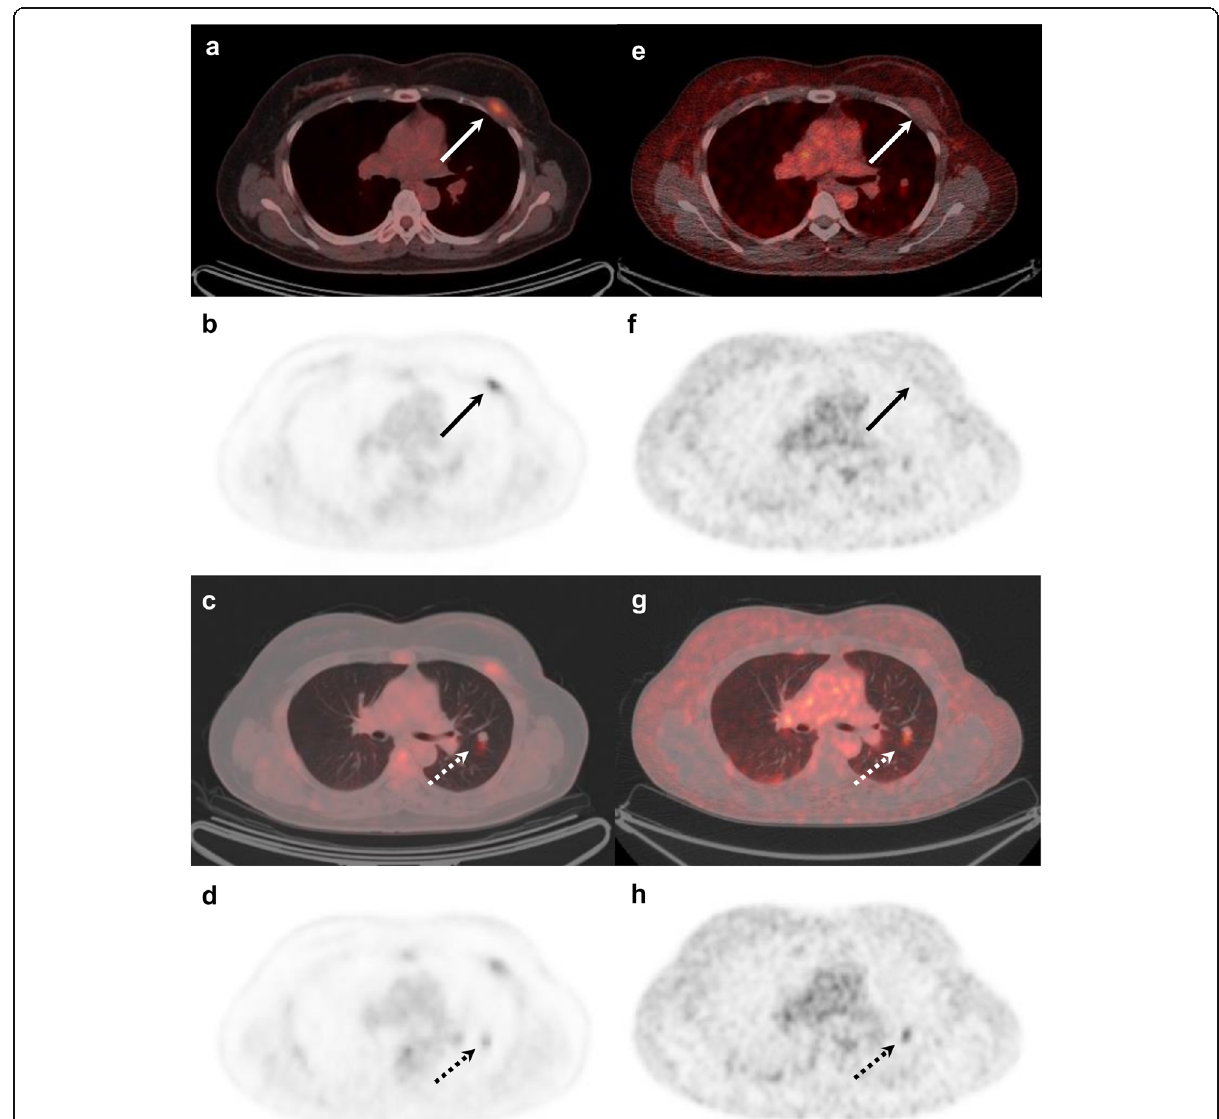
Fig. 3 [ 18 F]FDG and [ 18 F]FES PET/CT images of a 51-year-old female with histologically confirmed ER-positive recurrence (Allred score 5) in the chest wall. Transaxial [ 18 F]FDG images show positive uptake in the left chest wall recurrence ( a , b ; arrows). Additional positive [ 18 F]FDG uptake is seen in the left lung ( c , d ; dotted arrows). By contrast, [ 18 F]FES PET/CT is negative in the chest wall ( e , f ; arrows) and positive only in the left lung ( g , h ; dotted arrows). The left lung lesion was later confirmed as ER-positive metastatic breast